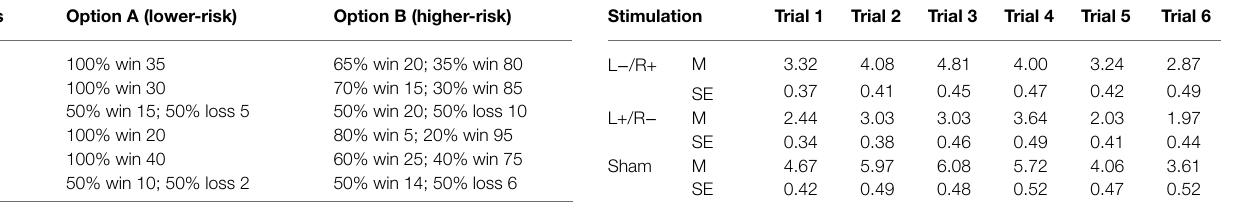
TABLE 1 | Gamble pairs used in the experimental tasks. Trials Option A (lower-risk) Option B (higher-risk)